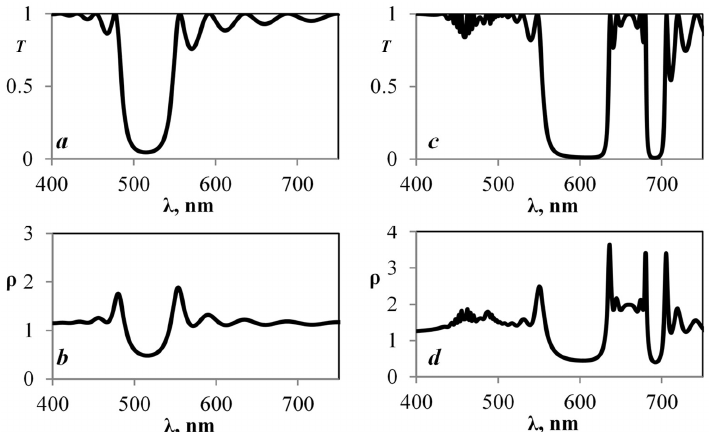
Figure 3. Design graphs for the periodic structure obtained with the help of the Cantor method. ( a ) Transmission spectrum excluding dispersion. ( b ) Graph of the density of photon states excluding dispersion. ( c ) Transmission spectrum including dispersion. ( d ) Graph of the density of photon states including